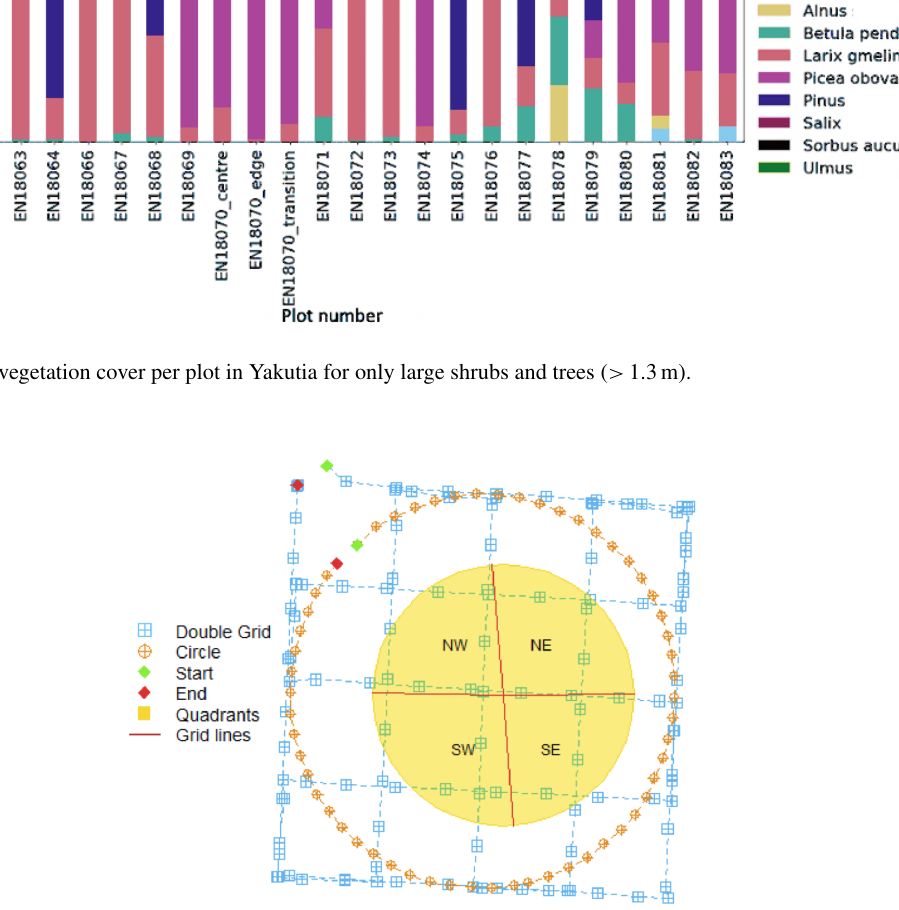
Earth Syst. Sci. Data, 14, 4967–4994,